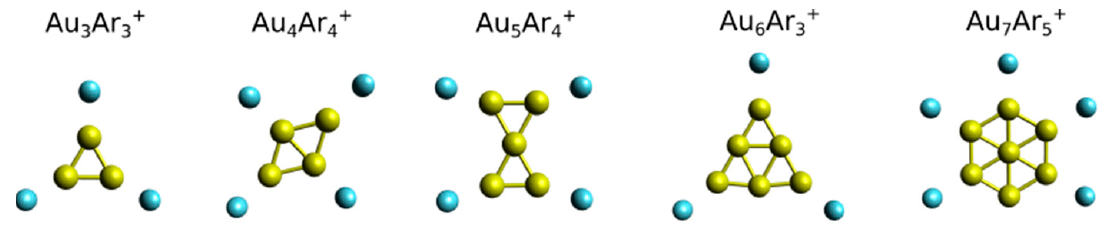
Figure 3. Optimized geometries of a selection of Au n Ar m + ( n = 3–7) clusters with multiple Ar atoms attached.